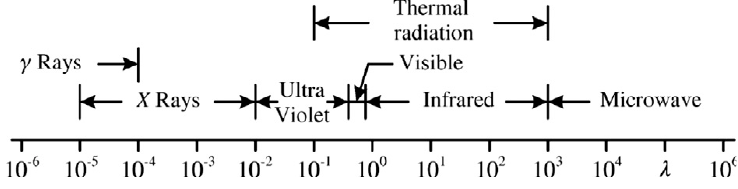
Figure 1. Electromagnetic spectrum ( Λ in micrometers (µm)).